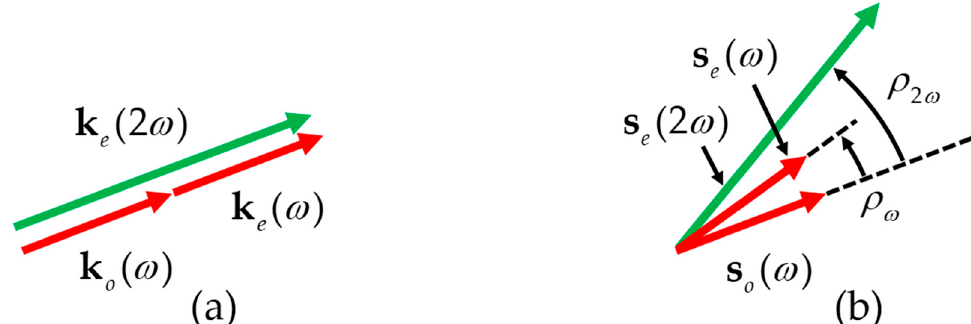
Figure 2. Example schematic diagrams showing the relationships of ( a ) wave vectors ( k e , k o ) and ( b ) Poynting vectors ( s e , s o ) of the interacting waves under Type II PM. Each ρ represents the walk-off angle between k and s . The angular scale is exaggerated.